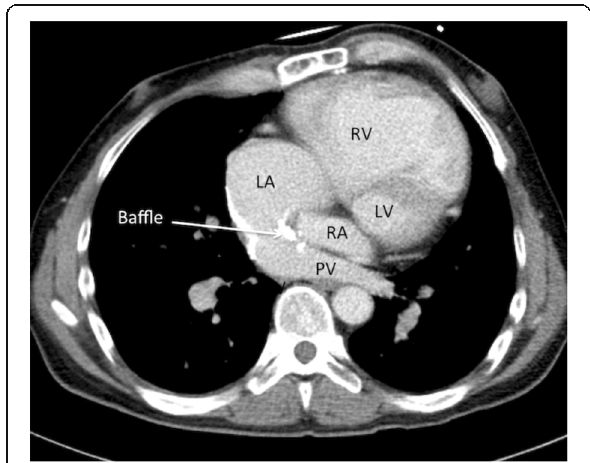
Fig. 2 Computed tomography just before systemic ventricular assist device implantation shows baffle calcification, a slightly narrowed pulmonary vein, and dilated left atrium and right